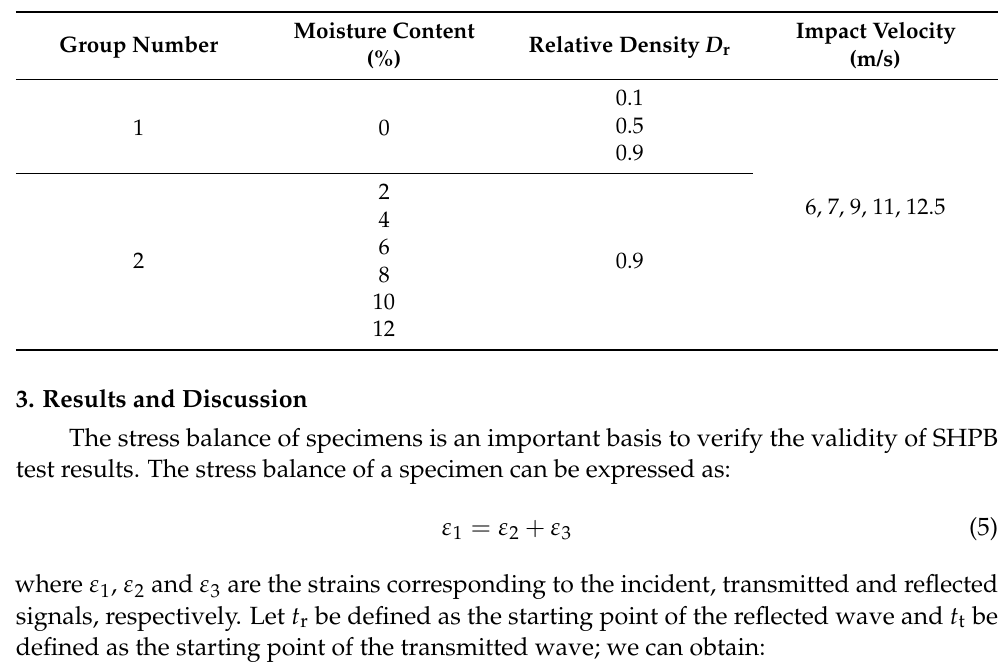
Table 2. Loading cases of current test